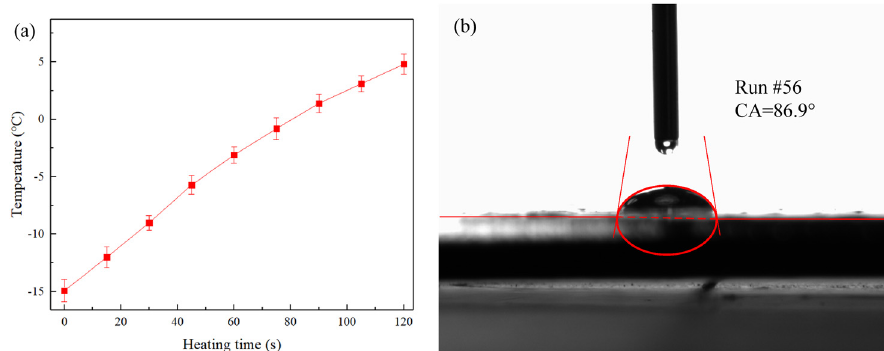
Figure 9: ( a ) Heating curve and ( b ) water contact angle of the optimized GO/PVB/EP nanocomposite